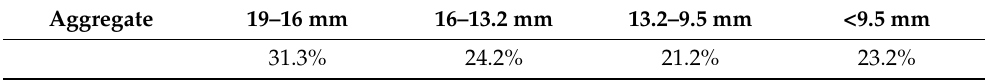
Table 2. Aggregate gradations.